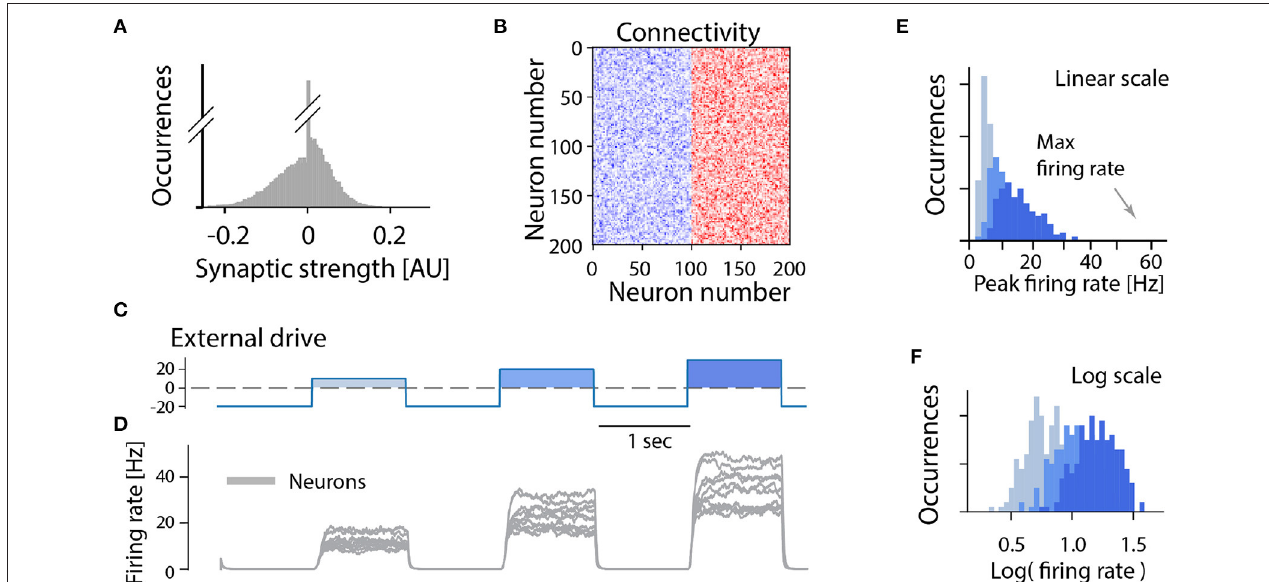
FIGURE 6 | Graded activity in a recurrent excitatory network balanced by inhibition: model. (A) Distribution of synaptic strengths in the model is a Gaussian, with a balance around zero. It also have many connections with zero strength (no connection). (B) Connectivity matrix of the non-zero connections in the network composed of 100 excitatory (blue) and 100 inhibitory (red) randomly connected neurons. (C) The external drive is negative (inhibitory) with positive pulses imitating a rhythmogenic input with increasing amplitude. (D) the firing rate of a subset of the neuronal population has diverse peak firing. (E,F) The linear- and log-scale distributions of peak firing rates are broad and skewed toward zero far from the maximal firing (arrow). The colors represent increasing external input, light blue: lowest, blue: middle, dark blue: largest input.